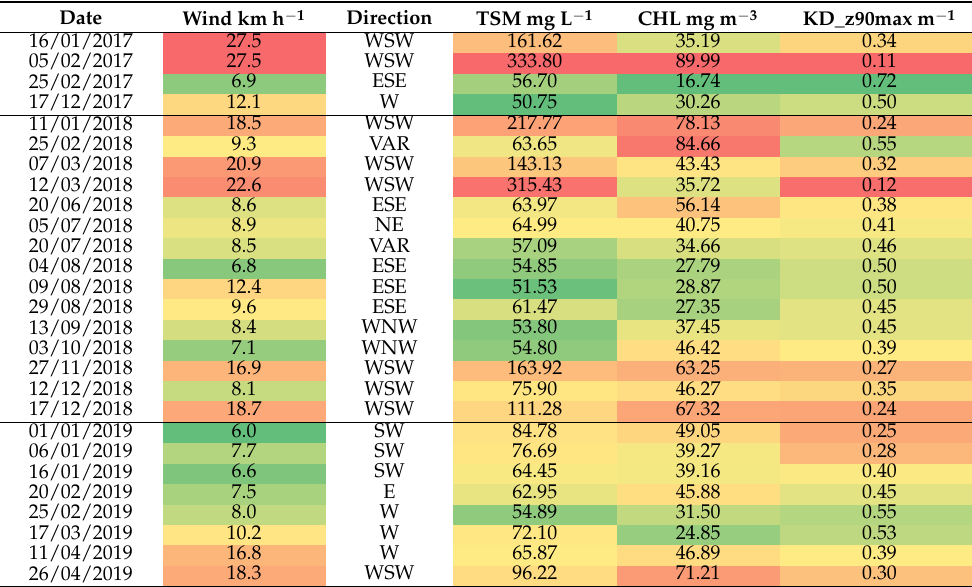
Table 2. Date of the selected images, indicating the mean wind speed in the previous 72 h; the dominant direction and the values estimated from the satellite image for total suspended matter (TSM), chlorophyll a concentration (CHL), and the diffuse attenuation coefficient of light penetration (KD_z90max). High (poor) values are presented in warm colors and low (good) values in cool